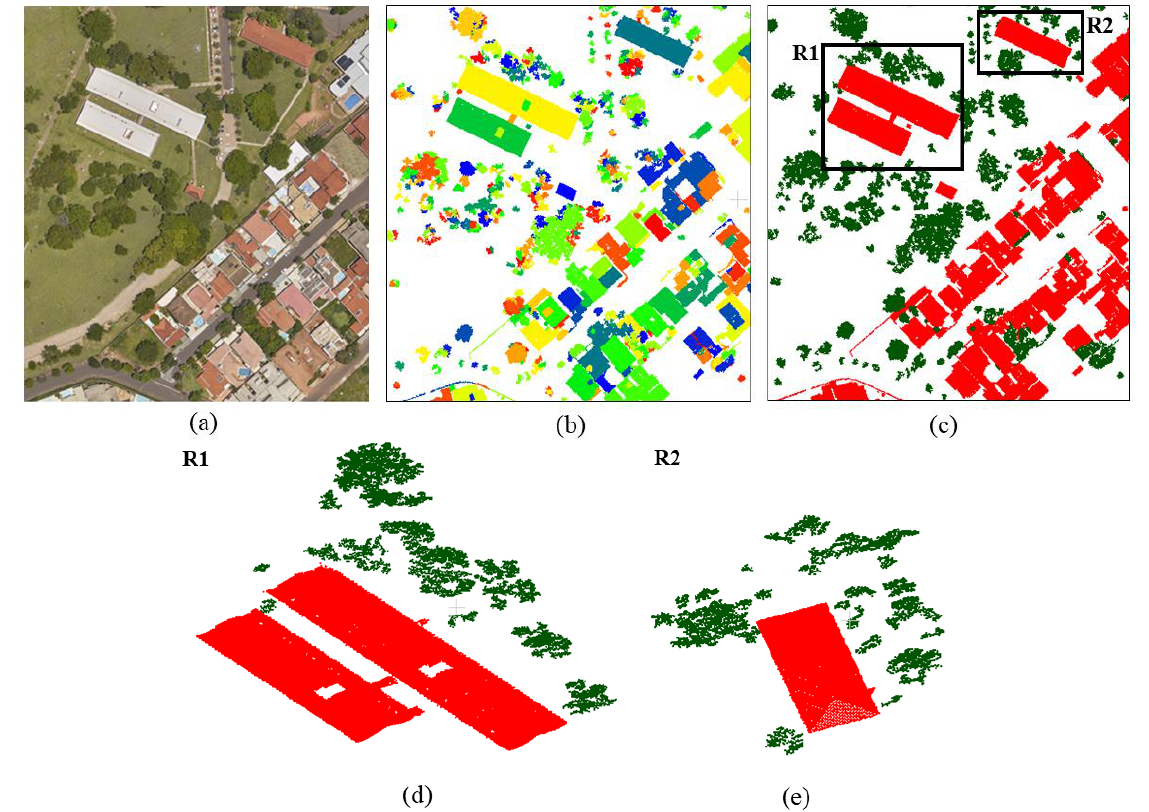
Figure 2. Presidente Prudente dataset. Aerial image (a), non-ground points after region growing process (b), and identification of building clusters using the proposed method (c).